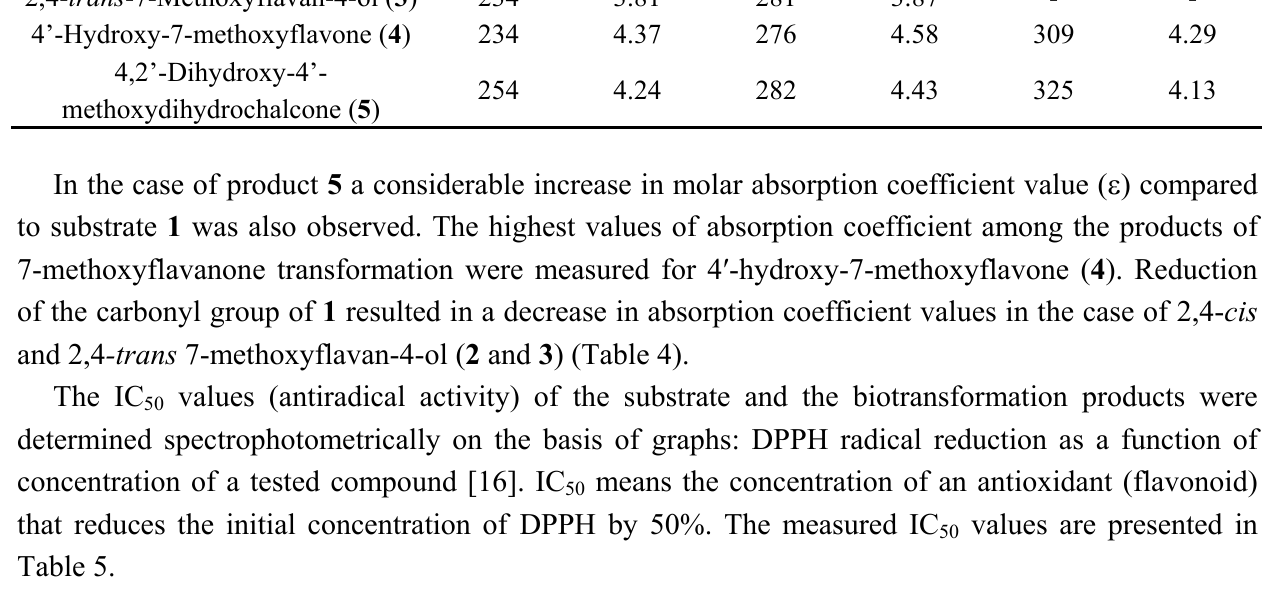
values of the 7-methoxyflavanone ( 1 ) and the biotransformation products. 50